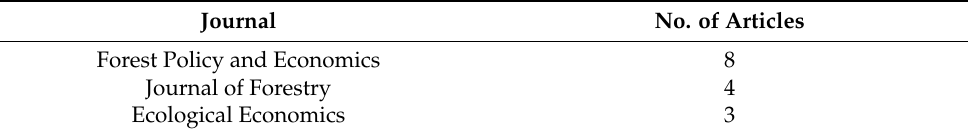
Table 2. The journals with the higher number of